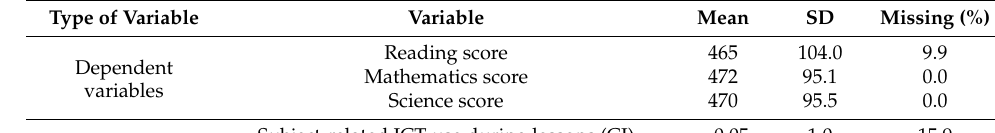
Table 2. Variable classification and descriptive